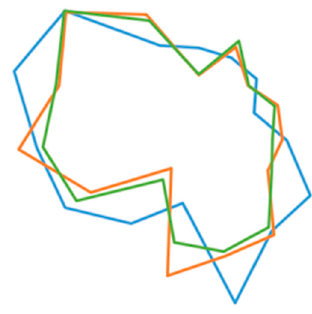
Figure 14. Deviation analysis of real, original Pearson and weighted Pearson.